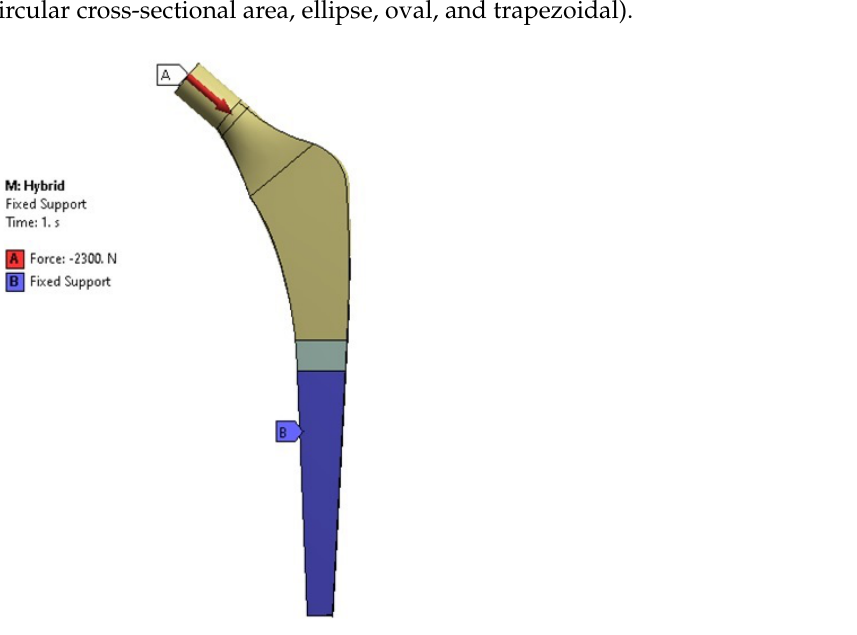
Figure 5. Boundary conditions considered as per ASTM F2996-13